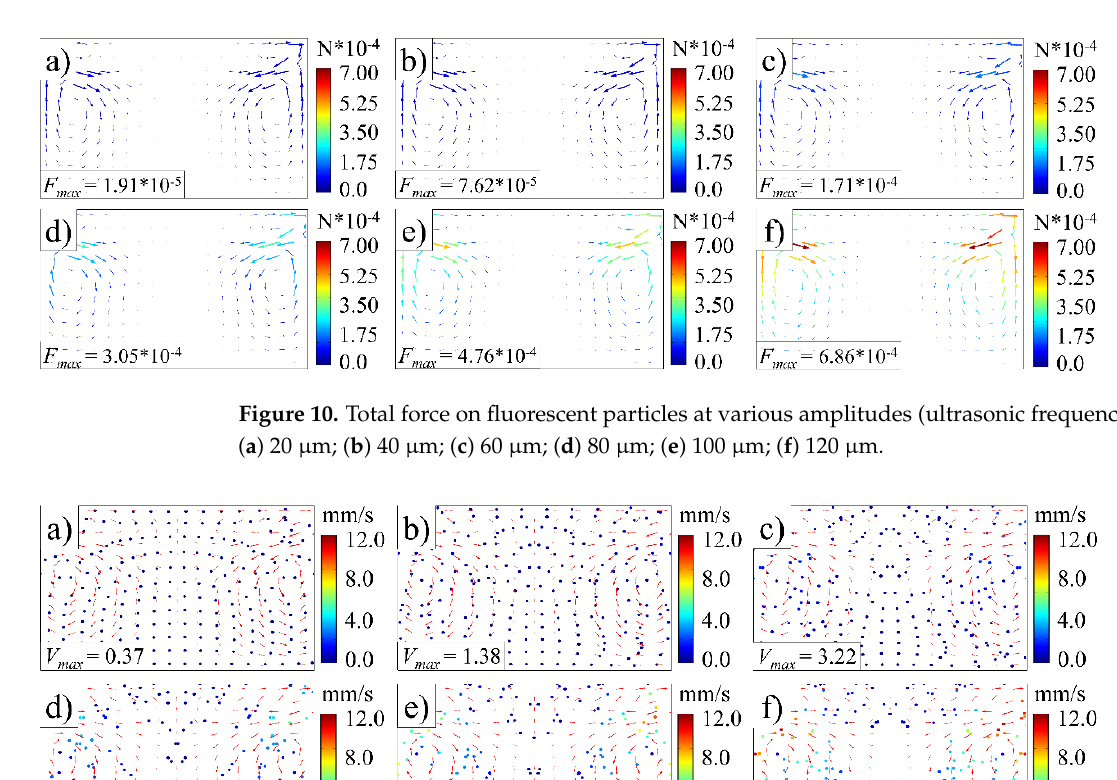
Figure 9. Influence of ultrasonic amplitude on the melt stream velocity in ( a ) radial and ( b ) axial directions.